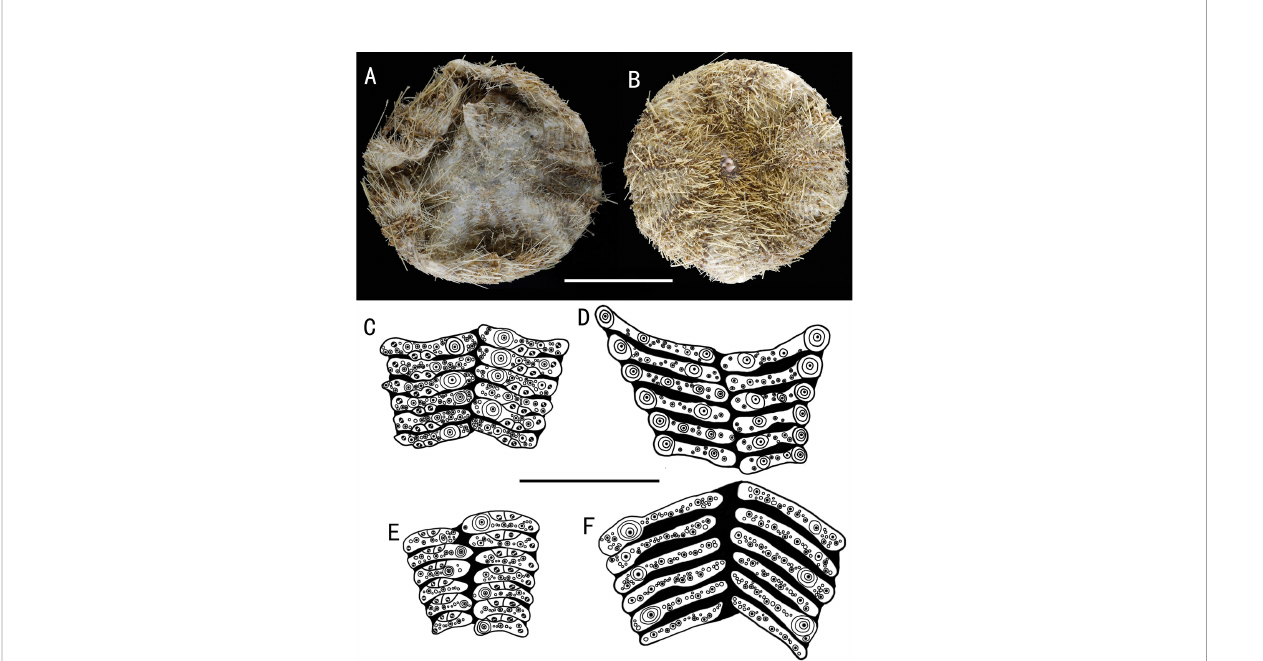
FIGURE 5 Araeosoma cucullatum sp. nov.; holotype, MBM286942 (test diameter, 105 mm). (A) Aboral view. (B) Oral view. (C – F) Details of the coronal plates: (C) , oral ambulacra (D) , oral interambulacral (E) , aboral ambulacra (F) aboral interambulacral. Scale bars , 50 mm (A, B) and 20 mm (C – F)